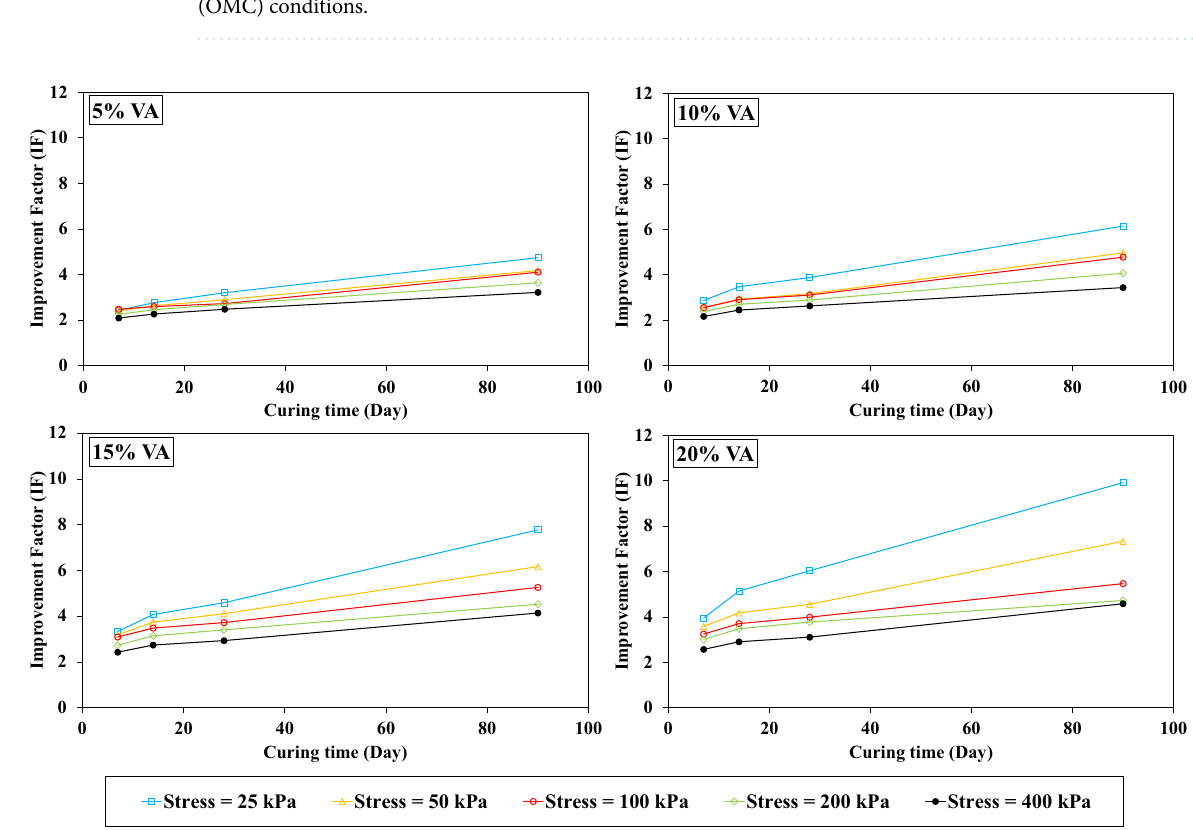
Figure 14. Influence of the curing time on the improvement factor (IF) for the saturated